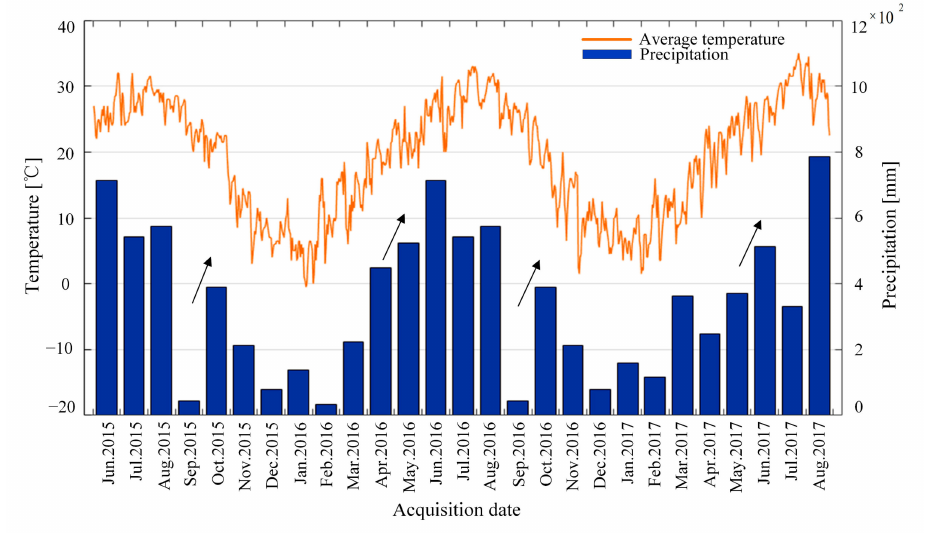
Figure 21. Air temperature and precipitation of the mining area (6 June 2016 to 31 January 2017)